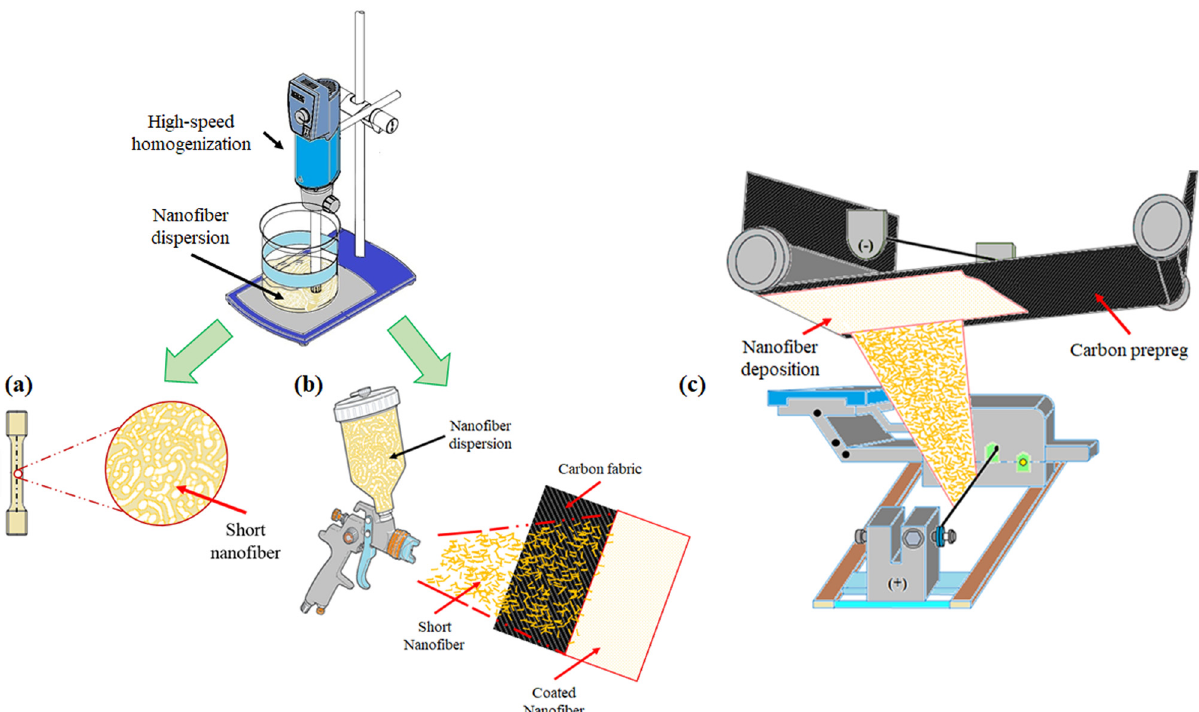
Figure 9: Short nano fi ber application in ( a ) bulk matrix modi fi cation, ( b ) spray deposition, and ( c ) direct spinning.